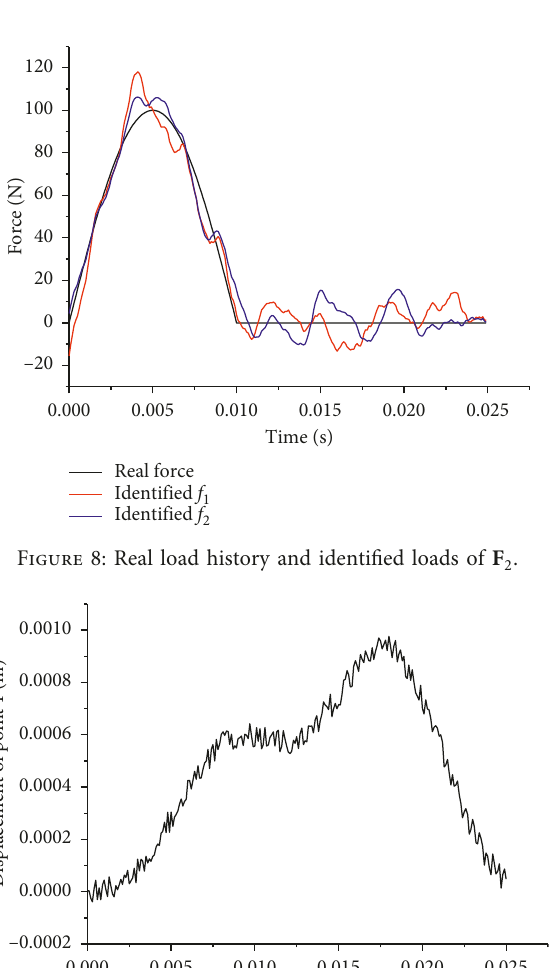
Figure 9: Displacement response of point 1 by F